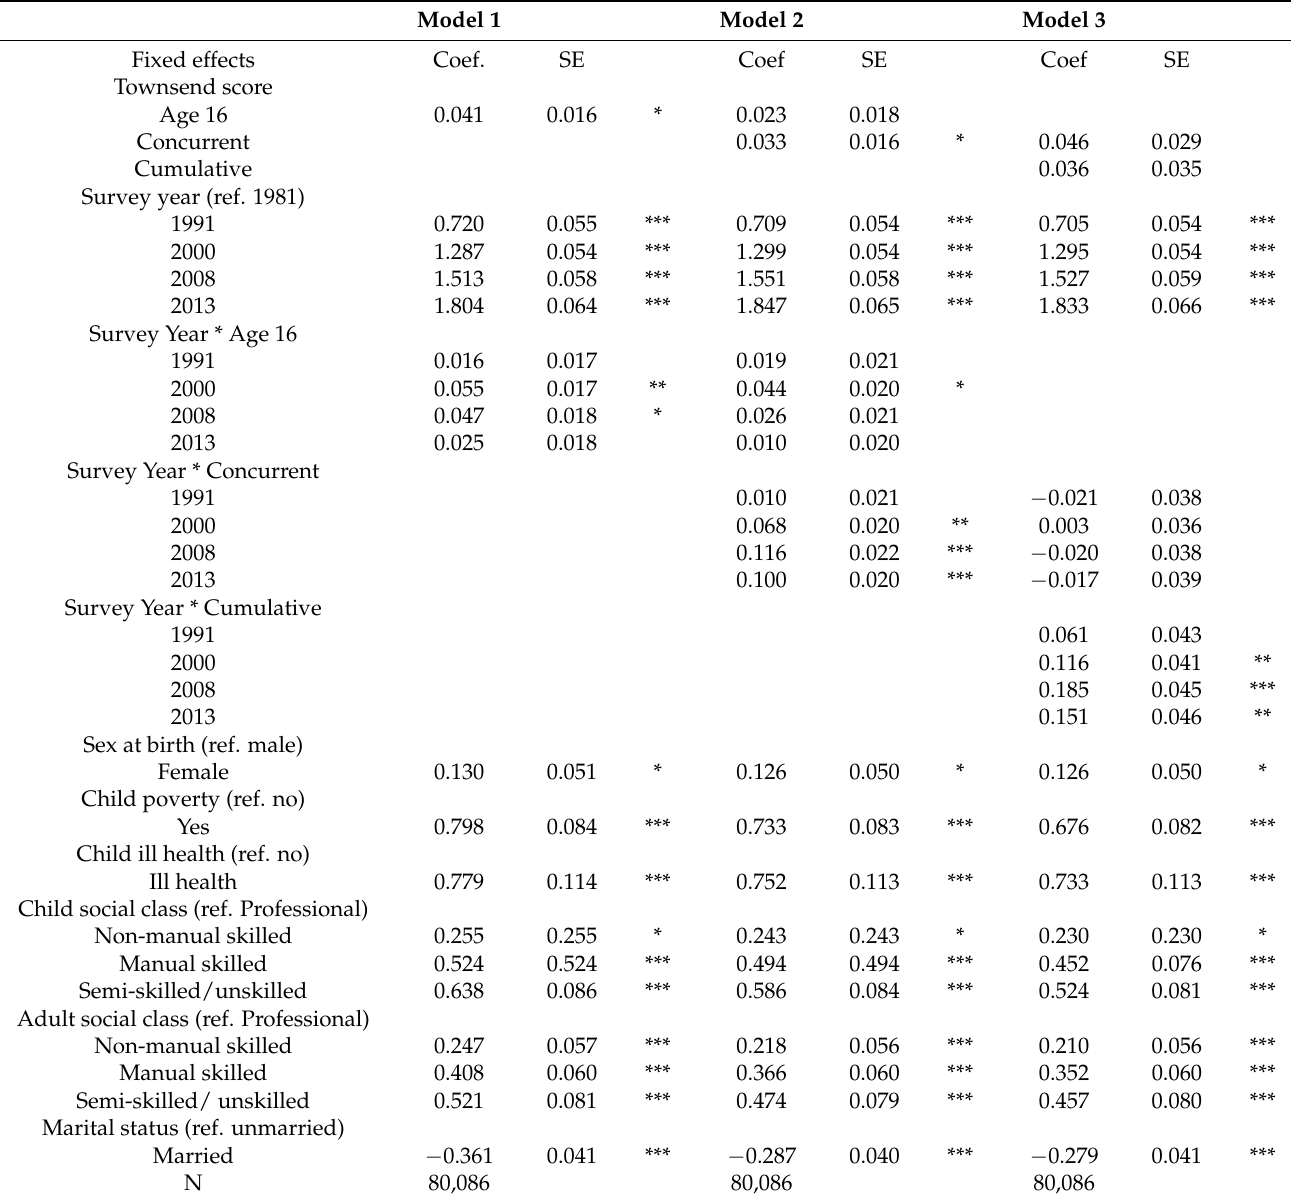
Table 2. Multilevel ordinal logistic regression estimates predicting worse than good self-rated